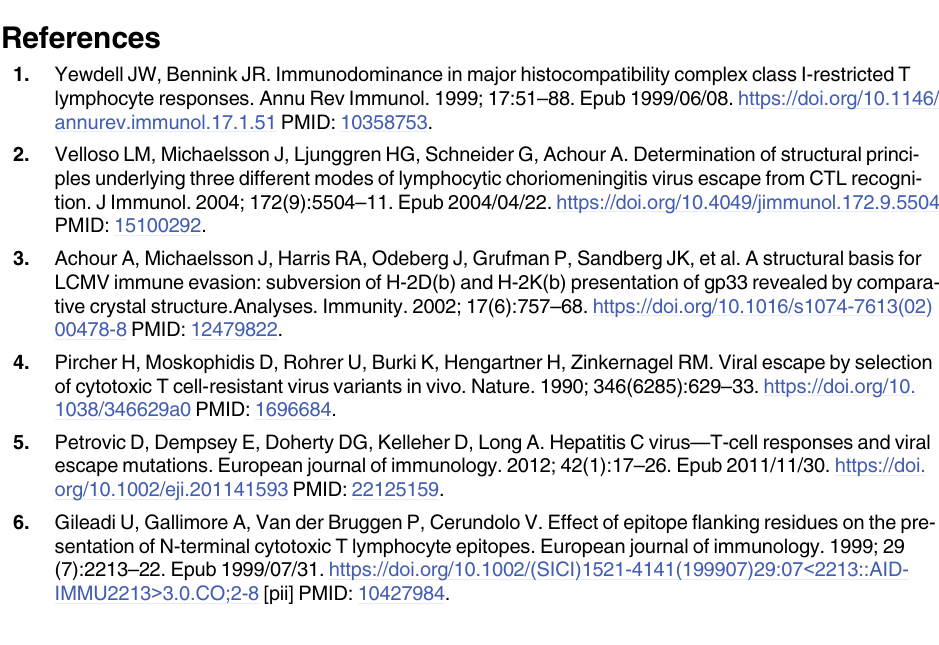
S1 Table. Data collection and refinement statistics for H-2D b /V3P and H-2D b /V3P_Y4F. S2 Table. Data collection and refinement statistics of P14 in complex with H-2D b